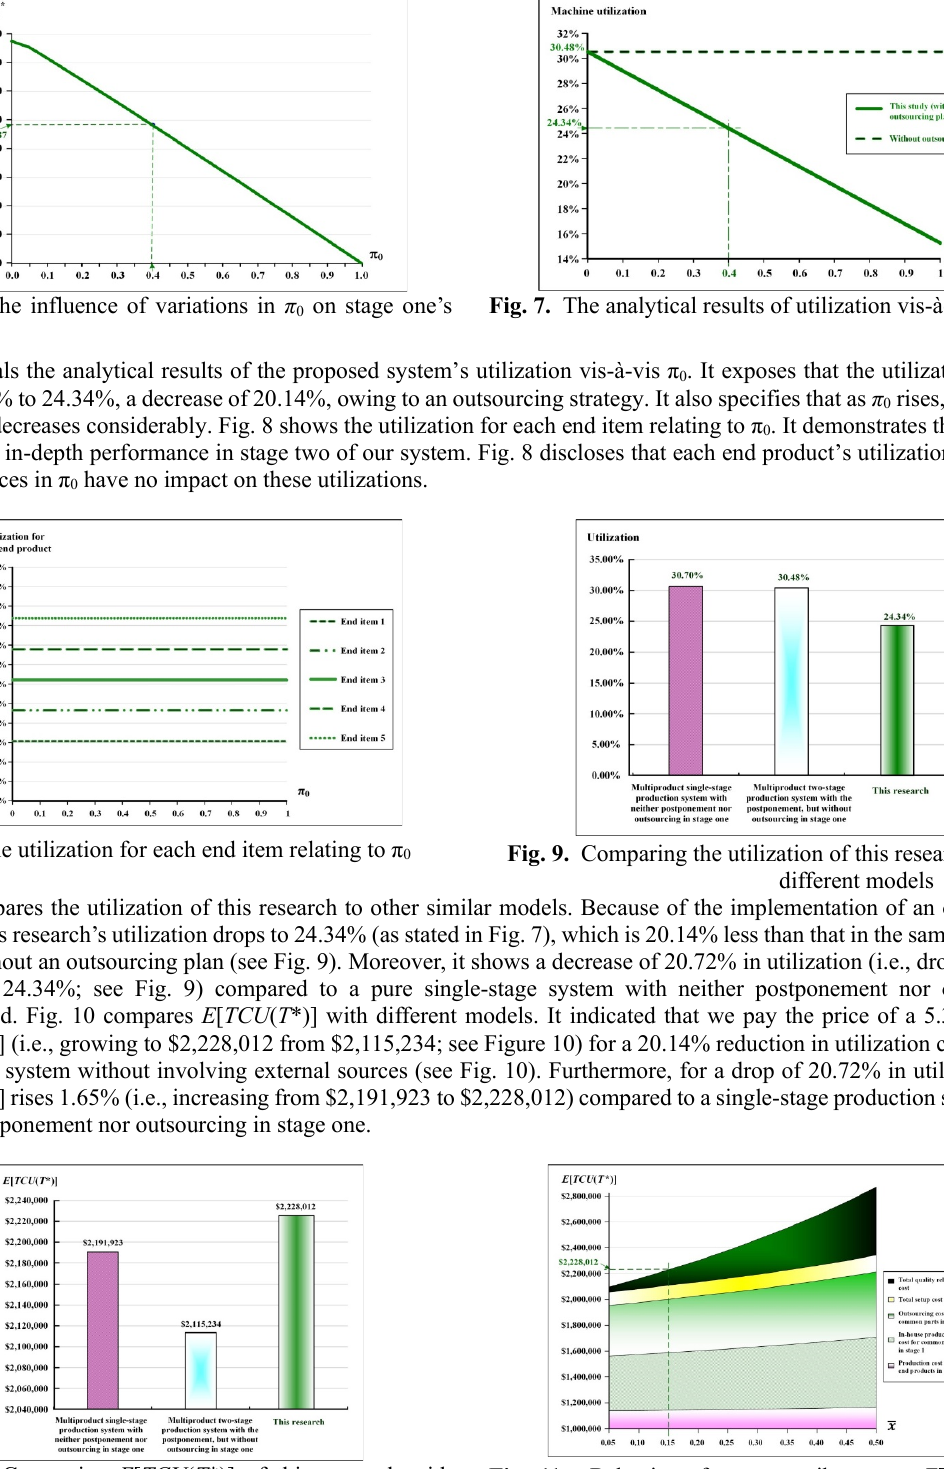
Fig. 11. Behavior of cost contributors to E [ TCU ( T *)] relating to